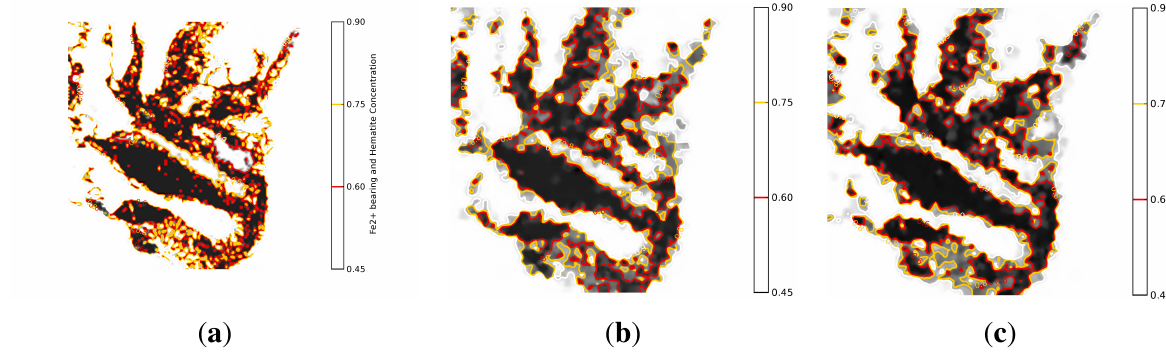
Figure 12. Contour maps generated by the three studied mapping